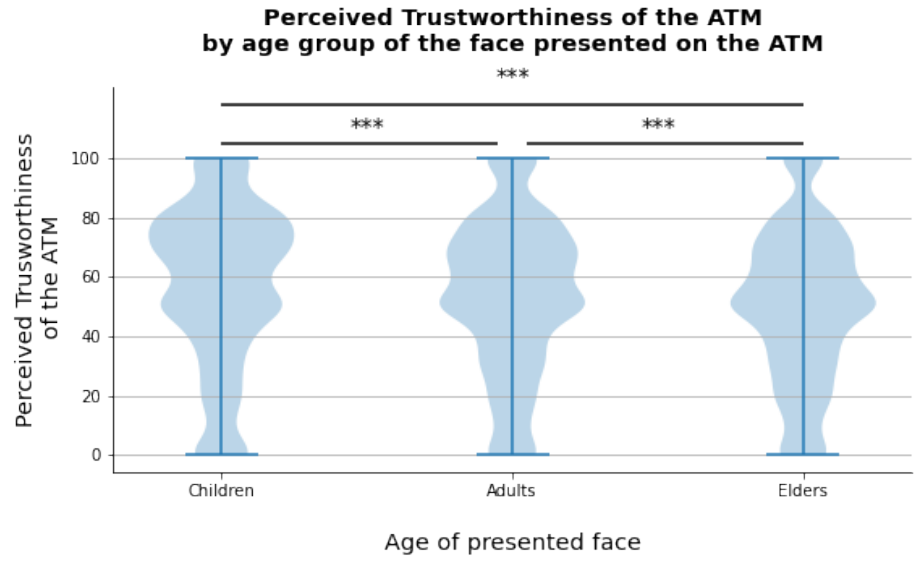
Figure 2. Distribution of Perceived Trustworthiness scores by age group (child, adult, or elder) of faces presented on ATMs. *** p <